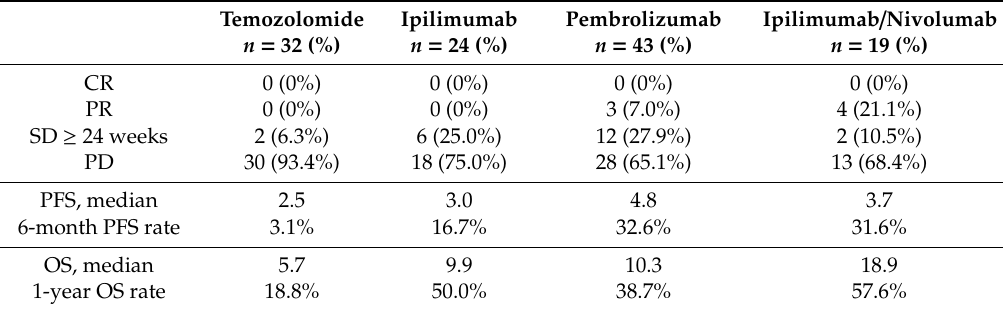
Table 2. Response per first-line